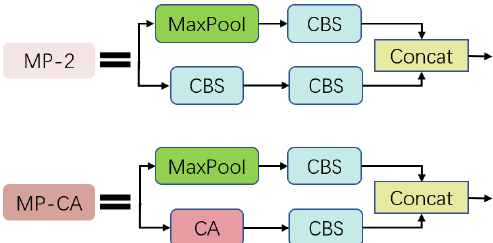
Figure 6. CA focuses on key information by participating in the calculation in MP